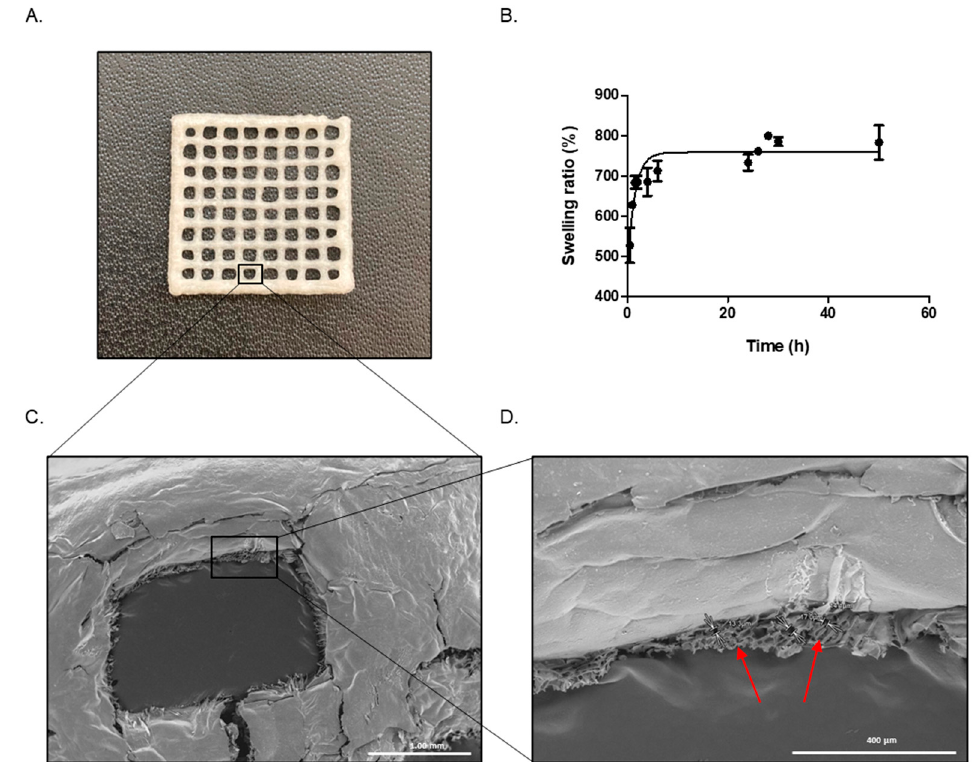
Figure 4. ( A ) Lyophilized GEL–ALG scaffold photograph. ( B ) GEL–ALG scaffold swelling determi- nation. Values represent mean ± SD. ( C ) Scanning Electron Microscopy (SEM) of GEL–ALG scaffold. ( D ) Close-up of the porous area observed in image ( C ).